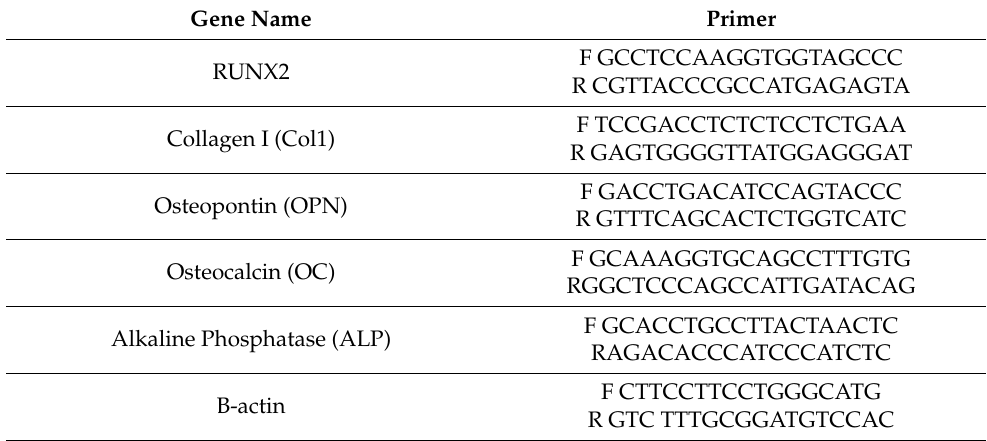
Figure 6. Osteogenic differentiation of OE-MSCs. ( A ) The extracellular matrix mineralization evaluation of encapsulated OE-MSCs in different concentration of collagen; The extracellular matrix mineralization was stained by Alizarin red S; quantifying the level of calcium production by Alizarin red S; ( B ) Osteogenic-related gene expression. Relative osteogenic marker expression of Runx2, Col1, OPN, OC, and ALP ( n = 3, * p < 0.05; ** p < 0.01; *** p < 0.001; **** p < 0.0001), (scale bar: 100 µ m). Table 1. Primer sequences for real-time